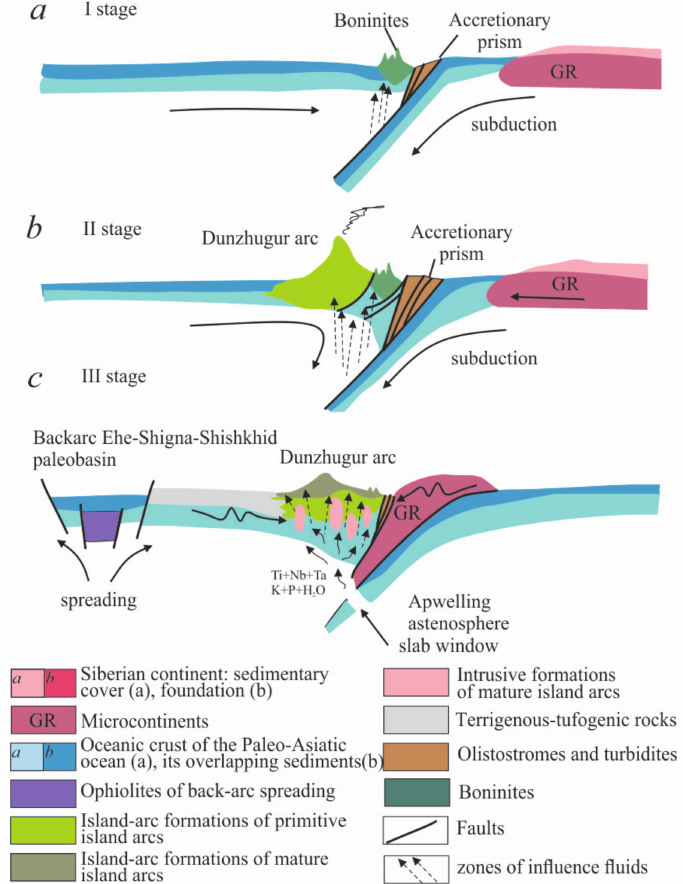
Figure 18. Simplified model of multistage magmatism at Neoproterozoic to Vendian-early Paleozoic time frame of a Pale-Asian Ocean